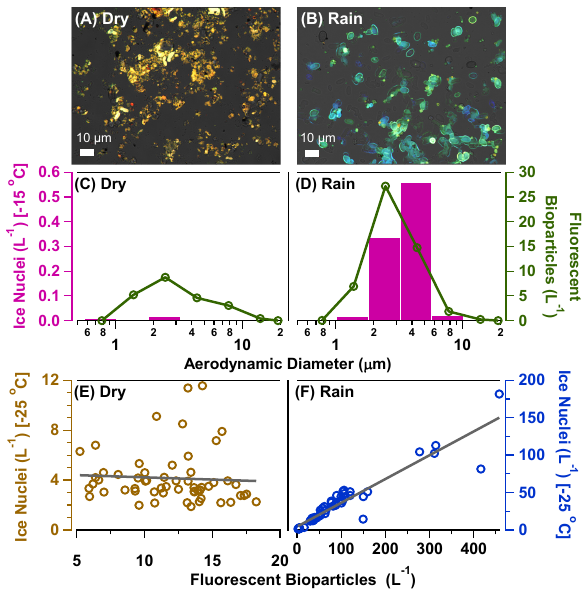
Fig. 3. Contrasting aerosol properties during dry periods and rain events. (A, B) Fluorescence microscope images of aerosol impactor samples. (C, D) Size distributions of ice nuclei observed at − 15 ◦ C in microscopic IN activation experiments (bars, left axis) and of fluorescent bioparticles detected by UV-APS (traces, right axis). (E, F) Number concentrations of ice nuclei observed at − 25 ◦ C in CFDC measurements plotted against fluorescent bioparticles de- tected by UV-APS (particle diameter < 2.4µm). The displayed lin- ear fits yield R 2 correlation coefficients of (E) 0.003 and (F) 0.88.